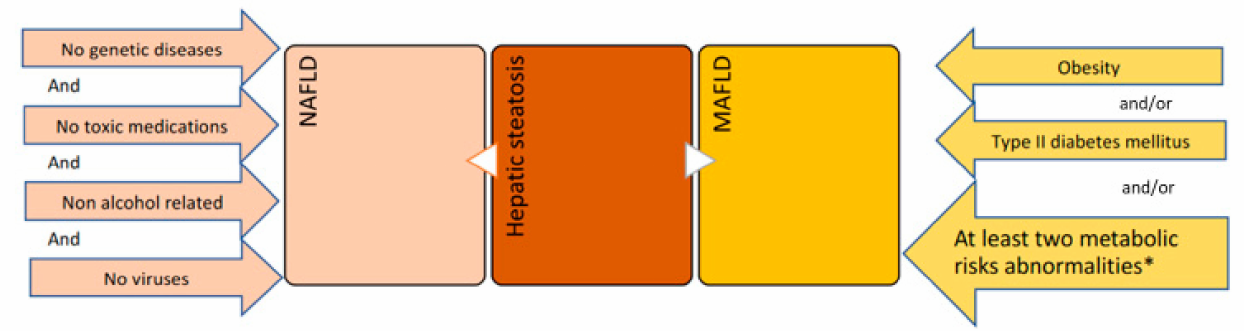
Figure 1. MAFLD vs. NAFLD diagnostic criteria. * Metabolic risk abnormalities: (1) Waist circum- ference > 102/88 cm in caucasian men/women or > 90/80 cm in Asian men/women; (2) Blood pressure ≥ 130/85 mmHg or antihypertensive medication; (3) Plasma Triglycerides > 150 mg/dl or triglycerides lowering drugs; (4) Plasma HDL-C < 40 mg/dl for men and < 50 mg/dl for women or specific lipid lowering drugs; (5) Prediabetes or HbA1c between 5.7–6.4%; (6) Plasma high-sensitivity C-reactive protein level > 2